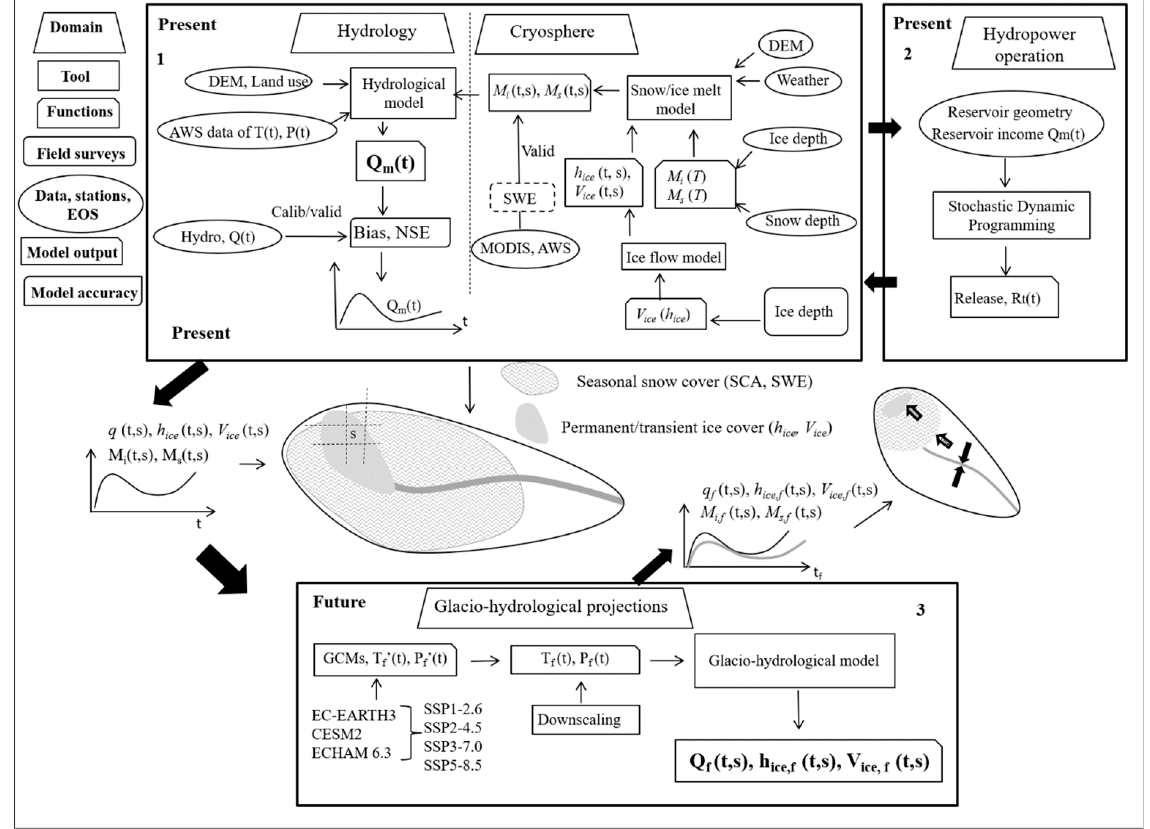
Figure 2. Poli-Hydro model, hydropower regulation for the control run period, and climate change scenarios simulations. We report the necessary tools as per 7 categories, i.e., domain (e.g., hydrology, reservoir operation), tools (e.g., hydrological model, optimization), functions (e.g., snow melt M s as a function of temperature M s ( T ), etc..), data (weather, terrain models, etc..), model outputs (e.g., snow melt in time and space M i ( t,s )), and model accuracy (e.g., Bias, NSE). Division in present, and future (projections) reported. T(t) is daily temperature, P ( t ) daily precipitation, Q ( t ) is daily observed discharge at outlet section, Q m (t ) is daily modelled discharge at outlet section, M s ( t,s ) is daily snow melt in a given place (cell), R t ( t ) is reservoirs’ release. Bias is systematic error on average, NSE is Nash-Sutcliffe Efficiency. T f ’ ( t ), P f ’ ( t ) are (future/projected) temperature and precipitation from GCMs before downscaling (biased), T f ( t ), P f ( t ) future daily temperature and precipitation after downscaling (unbiased), Q f ( t ) is projected